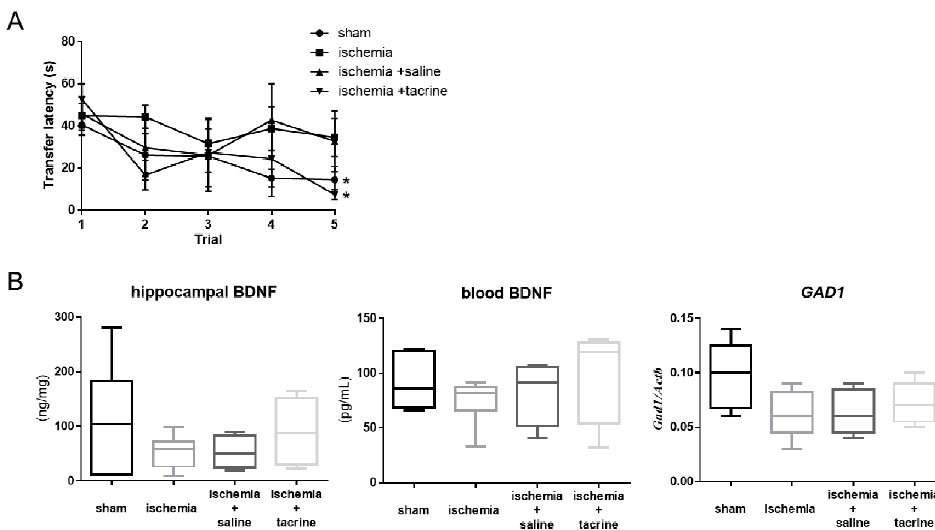
Figure 1. Behavioral performance and brain-derived neurotrophic factor (BDNF) and GAD1 expression patterns in a cerebral ischemia mouse model. ( A ) The transfer latency in the elevated plus-maze test was significantly different between five trials in each group. Differences between each group were assessed using two-way ANOVA (each group: n = 4–6). * p <0.05. ( B ) Hippocampal BDNF and GAD1 expression levels were lower in the ischemia group than in the sham group. Differences between each group were assessed using ANOVA (each group: n = 4–6).